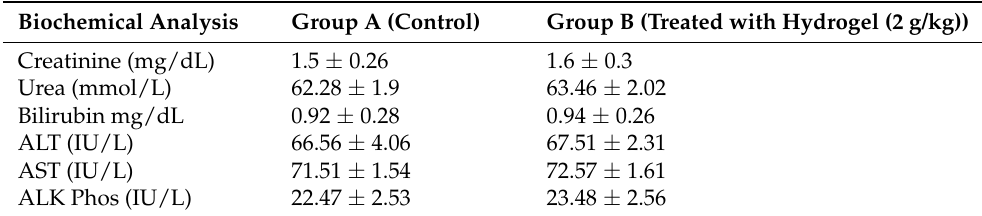
Table 5. Biochemical findings of the Na-CMC/pectin-co-polymeric (methacrylic acid) hydrogel after oral administration to